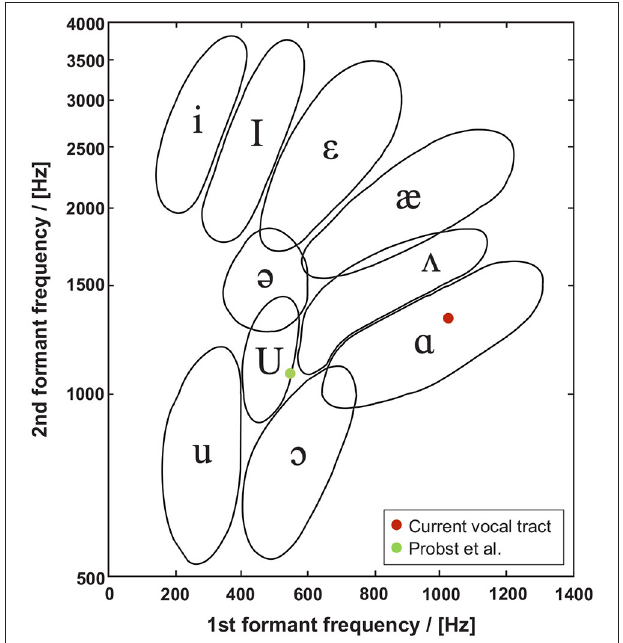
FIGURE 12 | CPP vs. the GC types with a symmetric (red points) and an asymmetric (green points) vocal fold motion. The CPP for the symmetric vocal fold motion almost remains at the same level for GC1 to GC3 followed by a decrease. The CPP for the asymmetric vocal fold motion decreases for an increasing glottal insufficiency. The CPP for the asymmetric motion is collectively smaller than those for the symmetric motion.